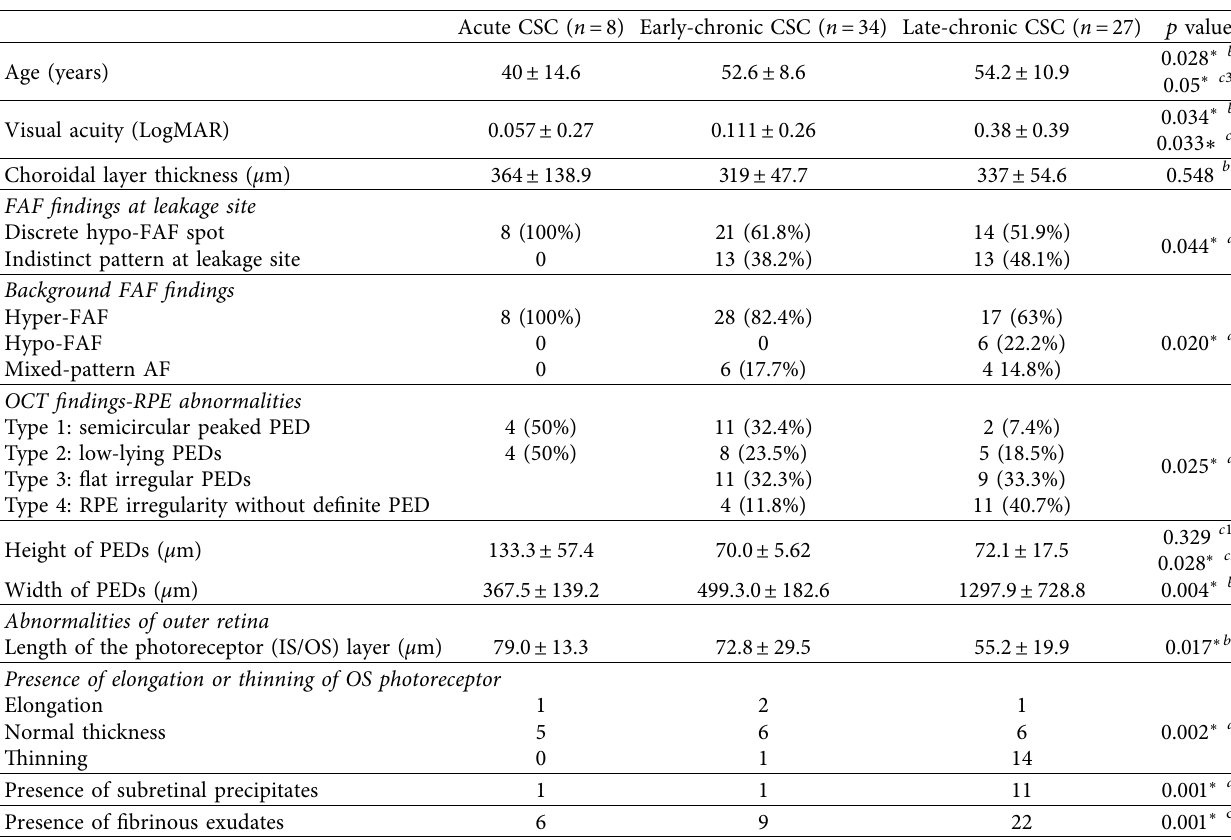
Table 2: Comparisons of the FAF and OCT findings between early-acute, subacute, and early-chronic CSC patients.